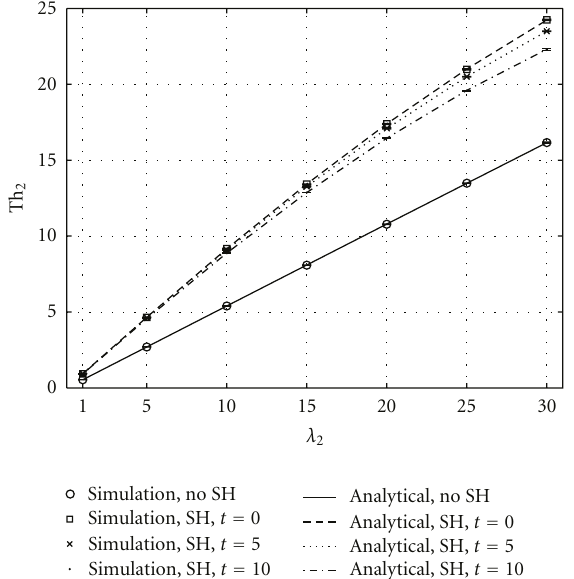
Figure 2: Throughput of SUs with the arrival rate of SUs when λ 1 = 4 . 4612.